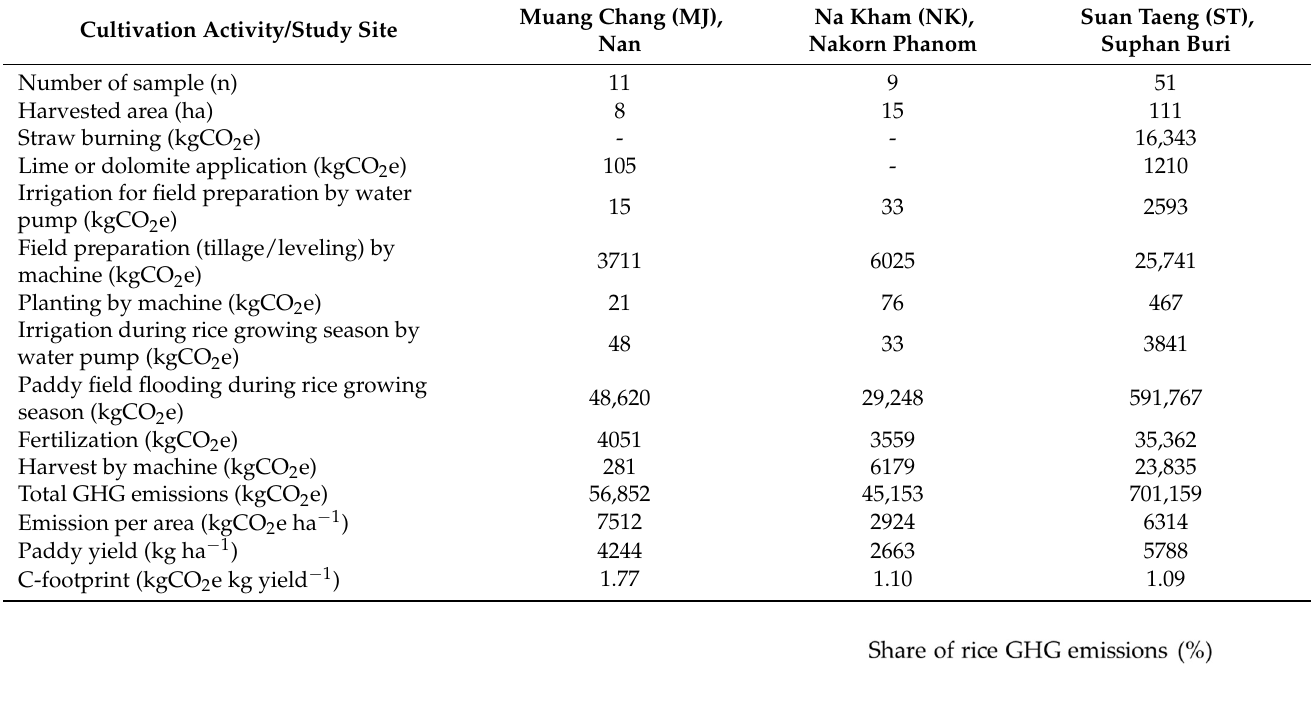
Table 2. Cultivation activity, amount of seasonal GHG emissions and C-footprint from three commu- nities in Thailand.